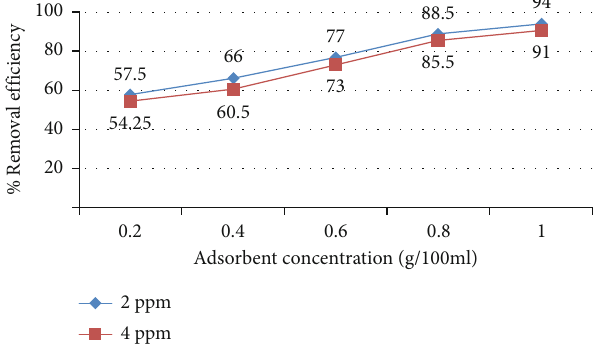
Figure 6: Neem stem charcoal adsorbent initial fl uoride concentration 2 PPM and 4